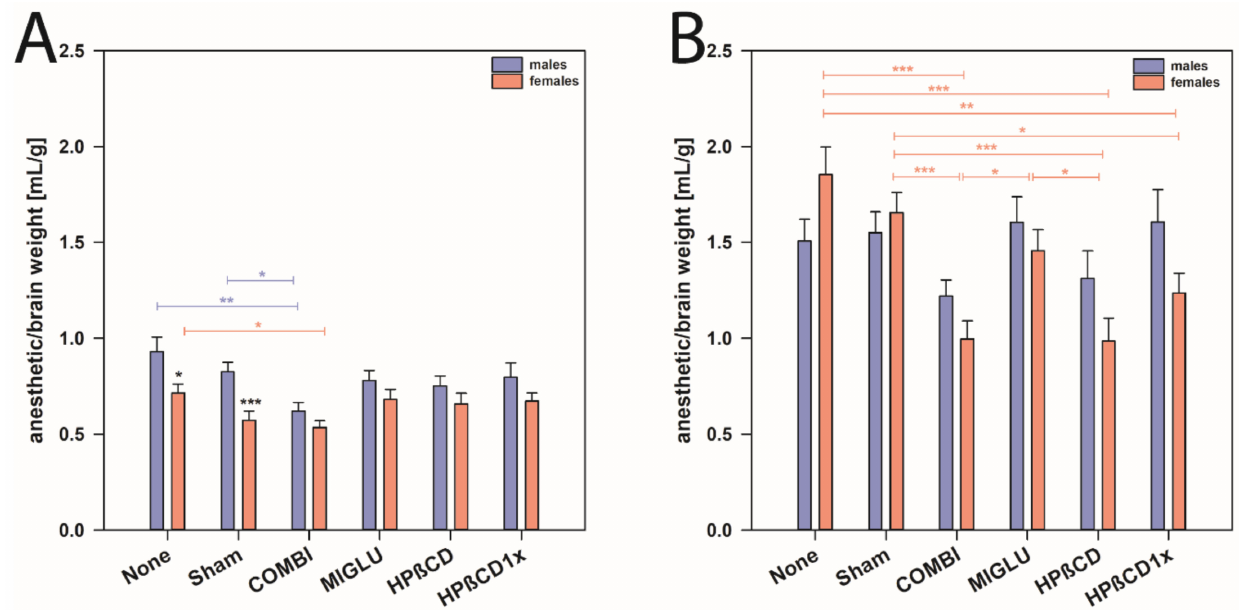
Figure 4. Anesthetic consumption/brain weight of male and female NPC1 mice. ( A ) NPC1 +/+ and ( B ) NPC1 − / − mice. Significant post-hoc tests are indicated by asterisks (* p < 0.05, ** p < 0.01, *** p < 0.001). Data are means ±